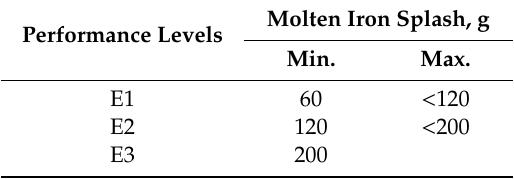
Table 5. Performance levels: molten iron splash [51].